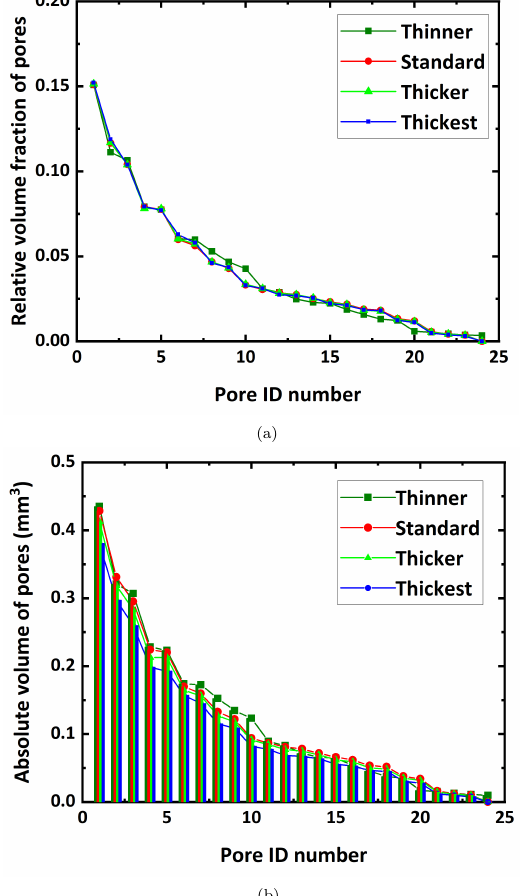
Figure 5. ( a ) The relative volume fraction (RVF) of pores, and ( b ) absolute volume (AV) of pores in various model domains with different strut thickness, as shown in Figure 4.